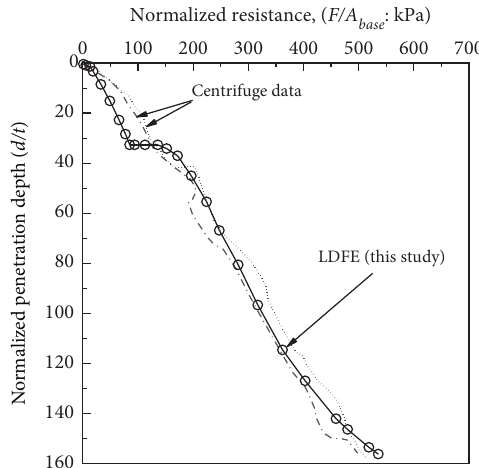
Figure 4: Validation in terms of resistance.